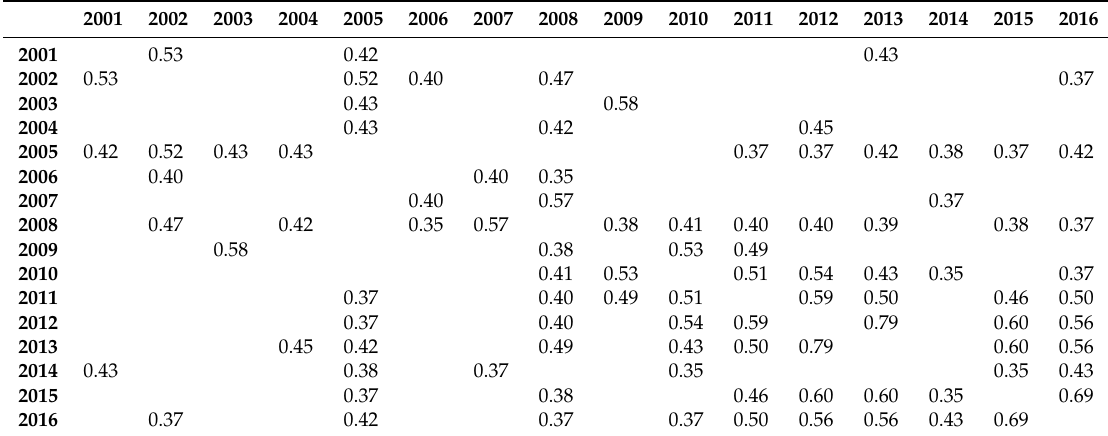
Table 5. Ranking of transport companies within entire monitored period (variant II.).